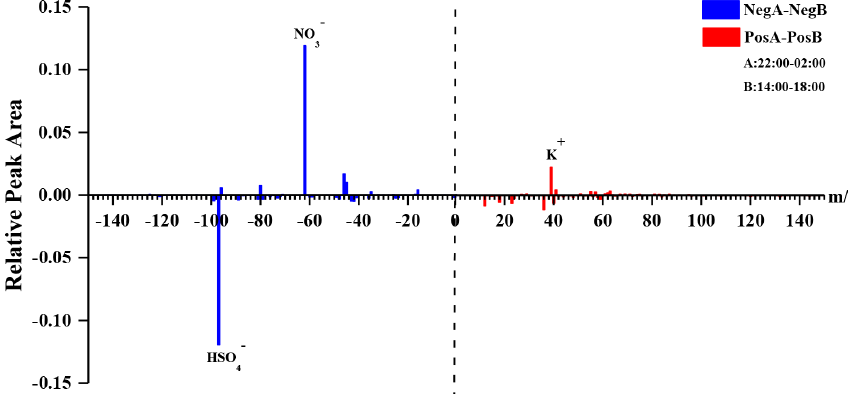
Figure 8. Differential mass spectra of DEA-containing particles between 22:00–02:00 and 14:00–18:00LT.